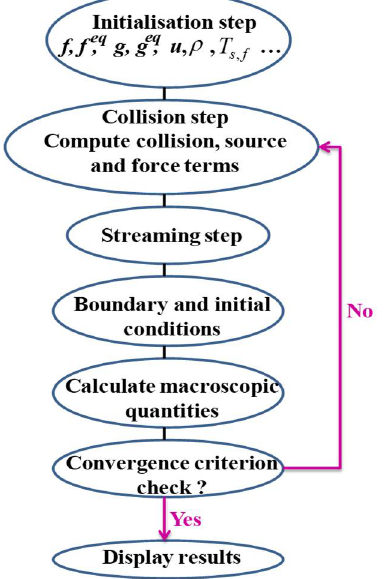
Figure 3. Diagrammatic flow chart of the present LBM.